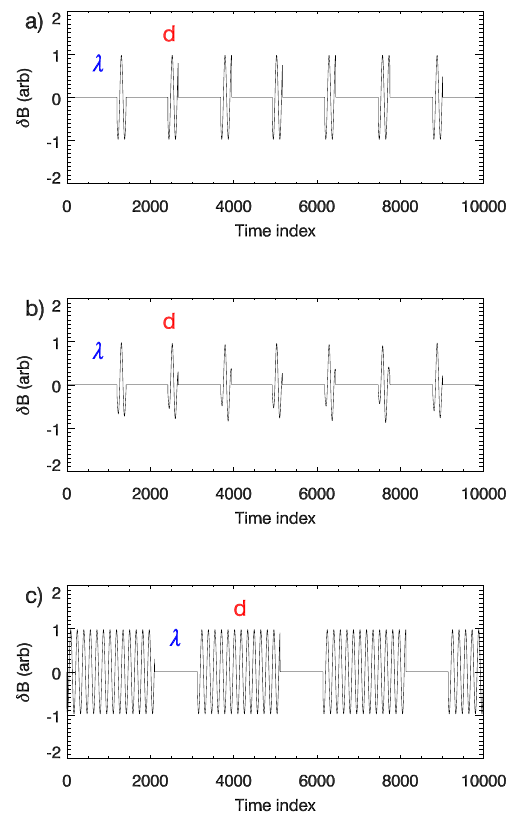
Figure 2. (a) Typical time series made up of structures with a mean spacing λ = 1000 time steps and d = 250 time steps. (b) Time series of structures which have been modulated by a Gaussian envelope. (c) Time series with λ = 1000, d = 2000. The values of λ and d vary with Poisson statistics, where the mean value is equal to the